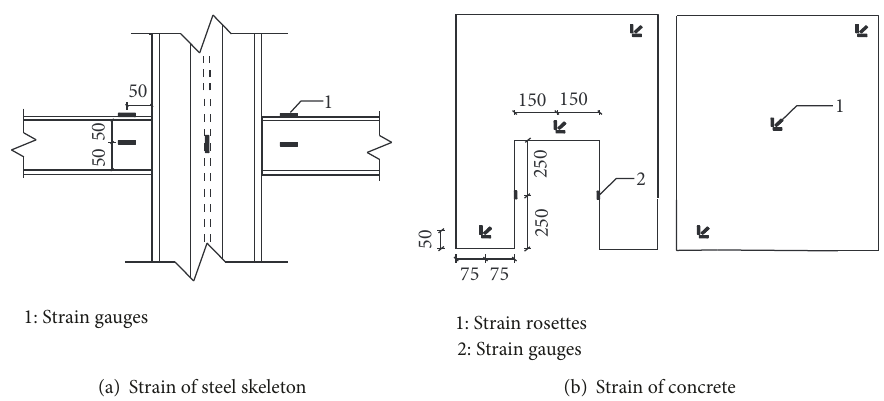
Figure 11: Arrangement of strain gauges and rosettes at the first and second floors (units: mm).